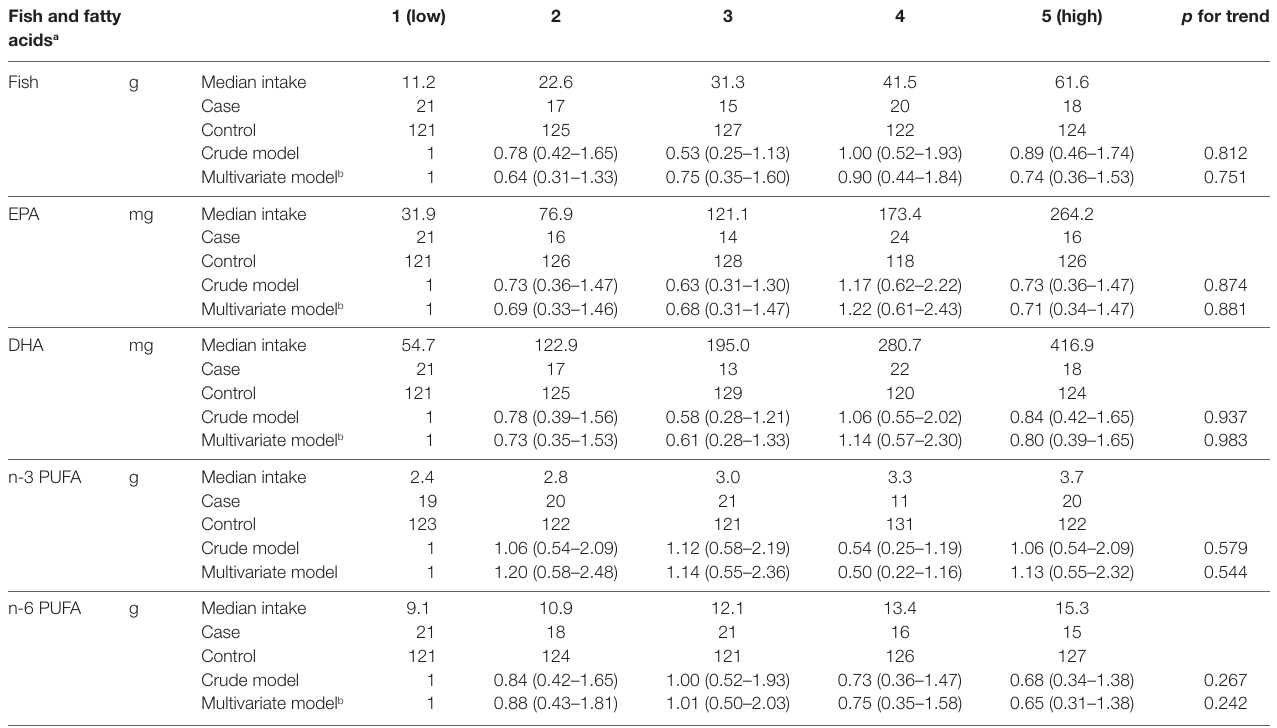
TaBle 4 | Odds ratios [95% confidence interval (CI)] for depression (EPDS score ≥ 9) at 6 months after childbirth according to quintile of fish and PUFA intake in late pregnancy. Fish and fatty acids